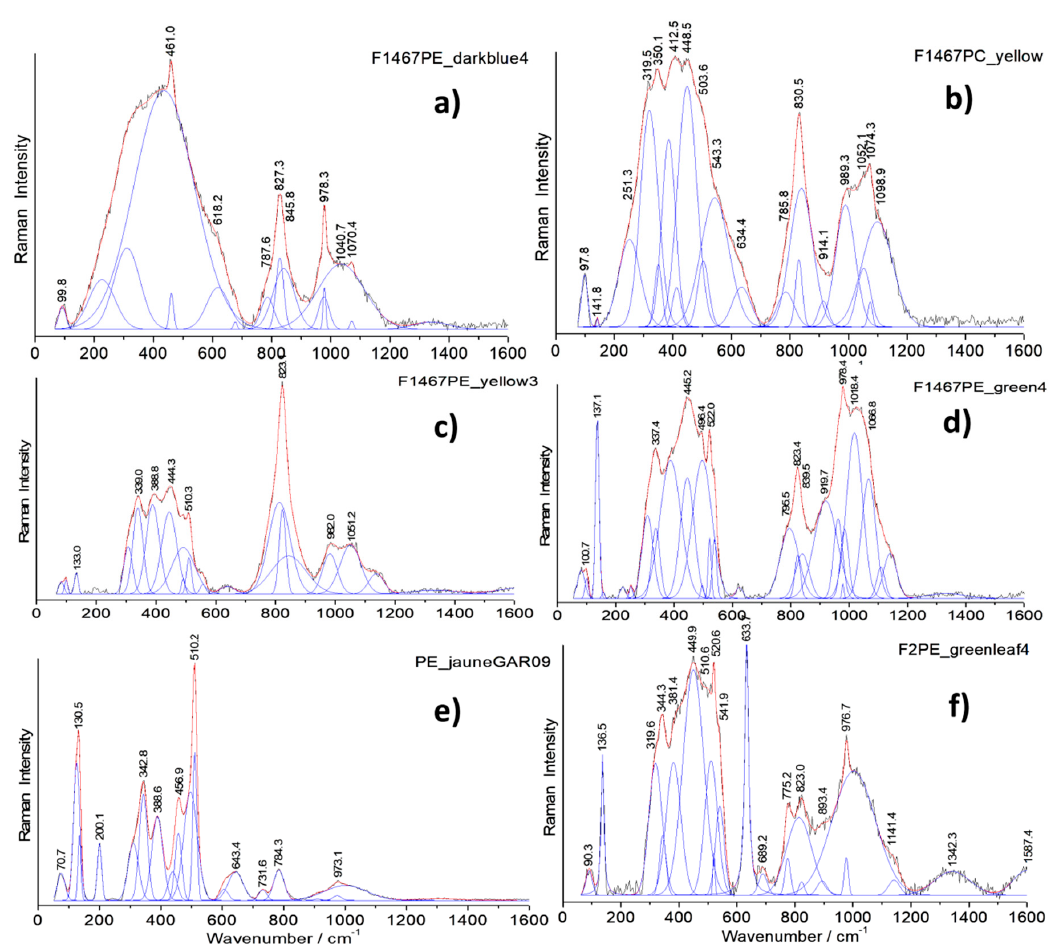
Figure 10. Representative Raman spectra recorded on the painted enamels of the ewer (baseline subtracted): dark blue ( a ), yellow ( b , c , e ), and green ( d , f ).